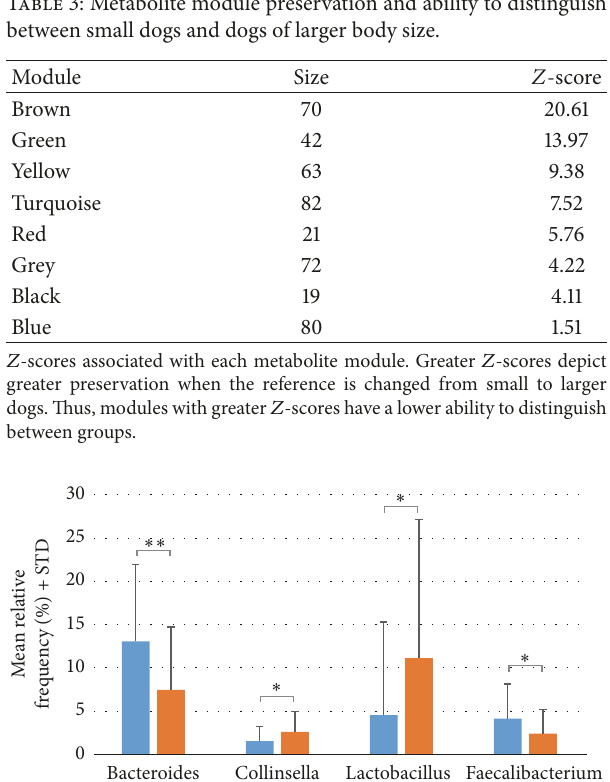
(higher in small dogs), and Collinsella and Lactobacillus (higher in larger dogs) had the highest mean proportion difference (mean relative frequency > 1%) (Figure